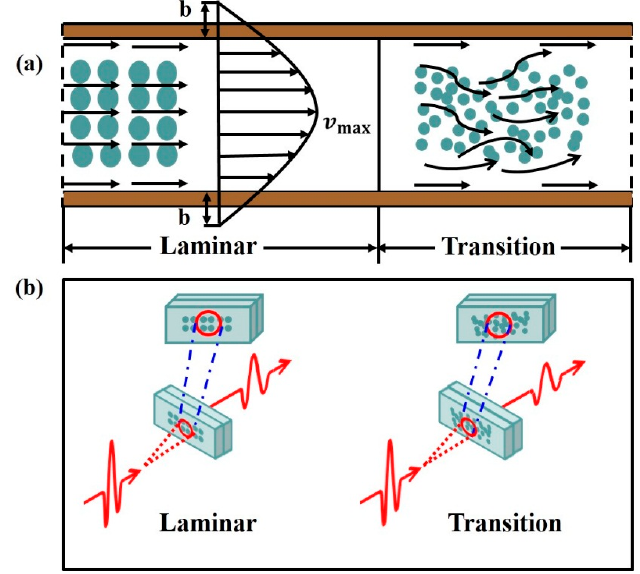
Figure 4. The schematic diagram for the interaction between THz wave and the flow. ( a ) The sketch map of laminar and transition; ( b ) Interaction between THz wave and the laminar and transition flow.